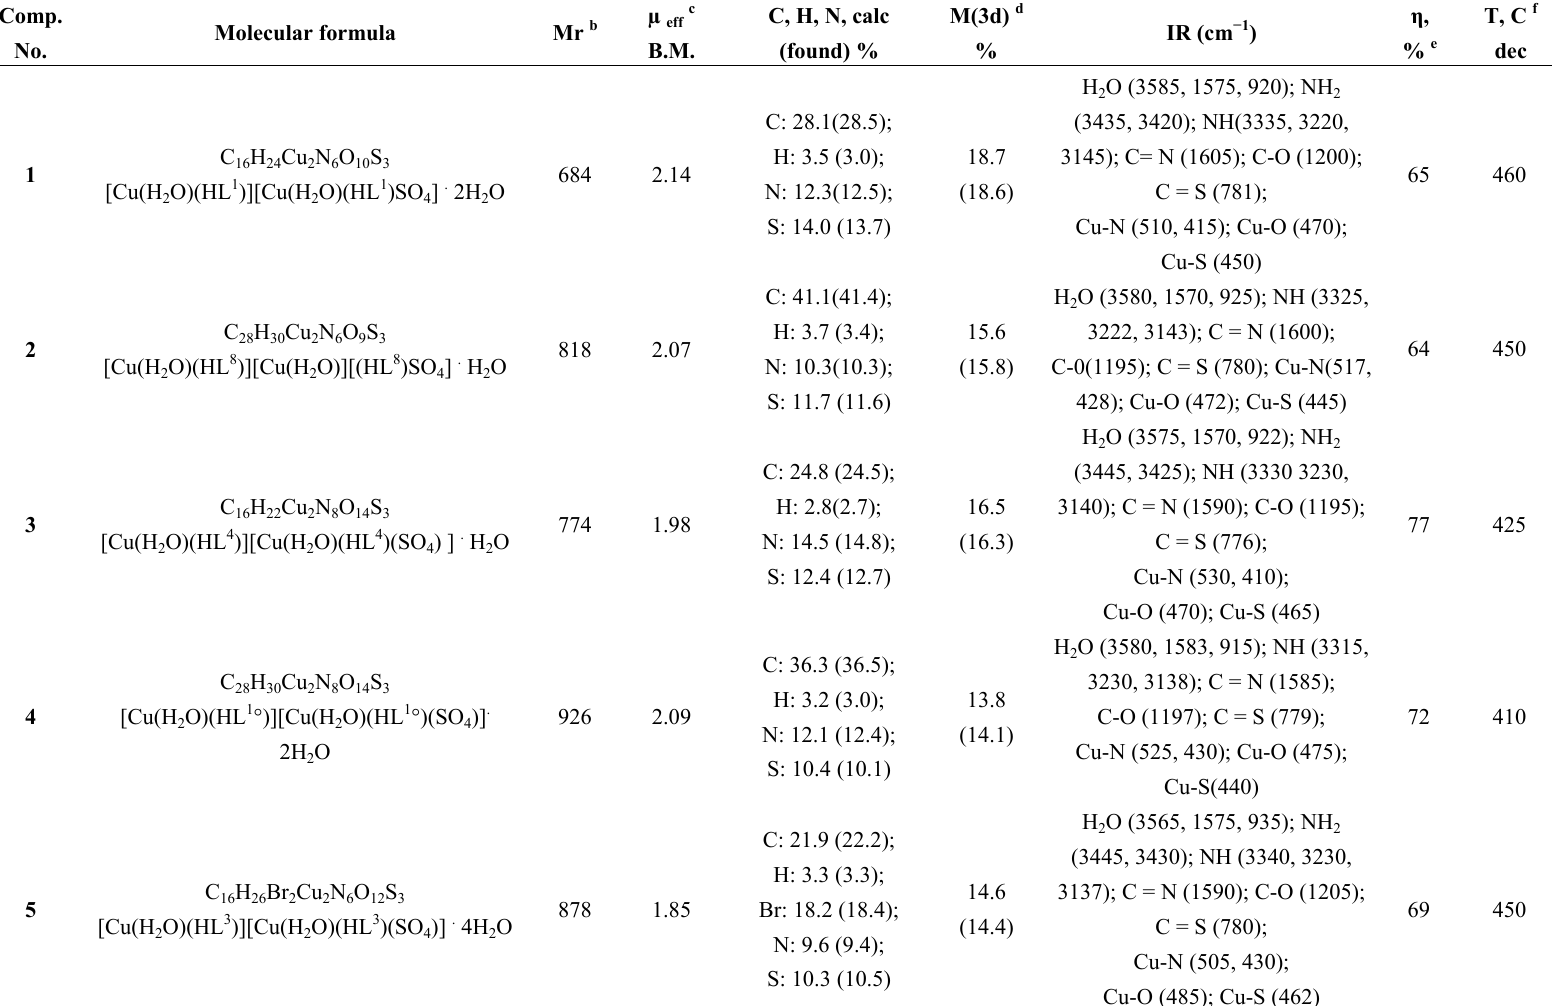
Table 1. Physical and analytical data of the metal complexes 1 – 32 a .